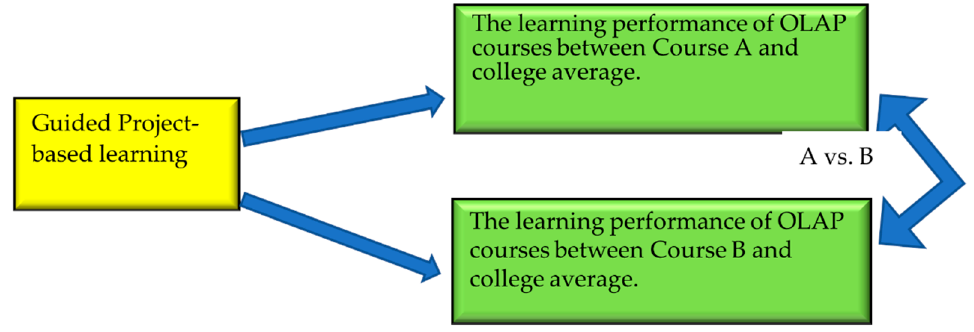
Figure 1. The chart of researched